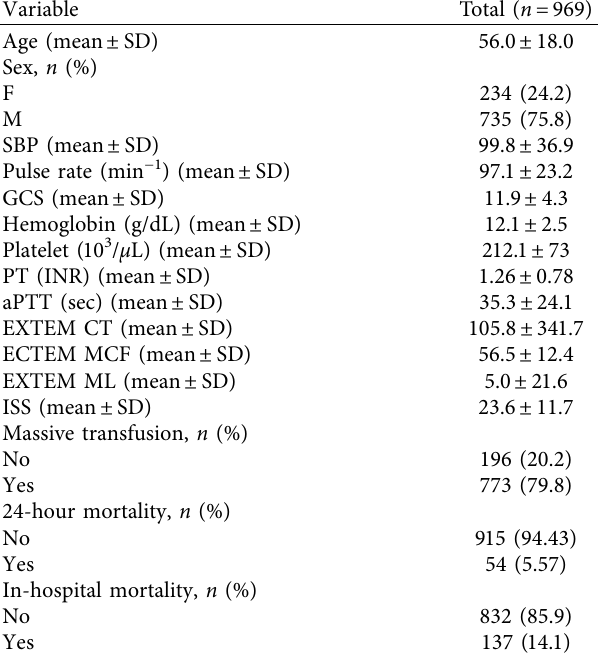
Table 1: Baseline characteristics. SD: standard deviation; SBP: Systolic blood pressure; GCS: Glasgow coma scale; PT (INR): prothrombin time (international normalized ratio); aPTT: acti- vated partial thromboplastin time; CT: clotting time; MCF: max- imum clot firmness; ML: maximum lysis; ISS: injury severity